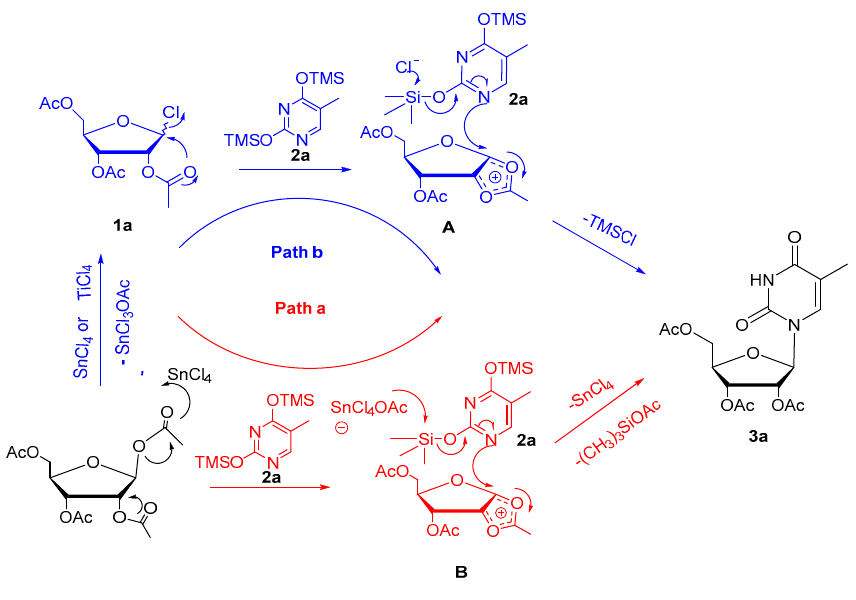
Figure 5. Mechanism for silyl-Hilbert-Johnson reaction.